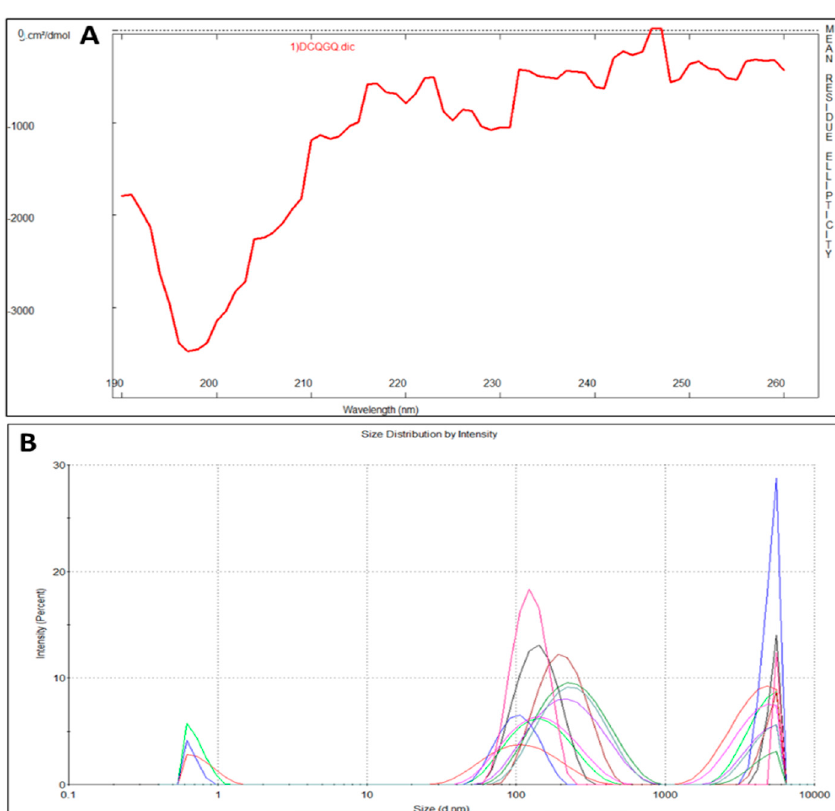
Figure 1. ( A ) Circular dichroism spectrum of cementum protein 1 C -terminal-derived synthetic peptide (CEMP1-p4). The lack of signals in the far UV region indicates that the peptide’s secondary structure is mainly random-coiled. ( B ) Dynamic light scattering measurements revealed the CEMP1-p4 peptide adopts three oligomerization states at 37 °C.